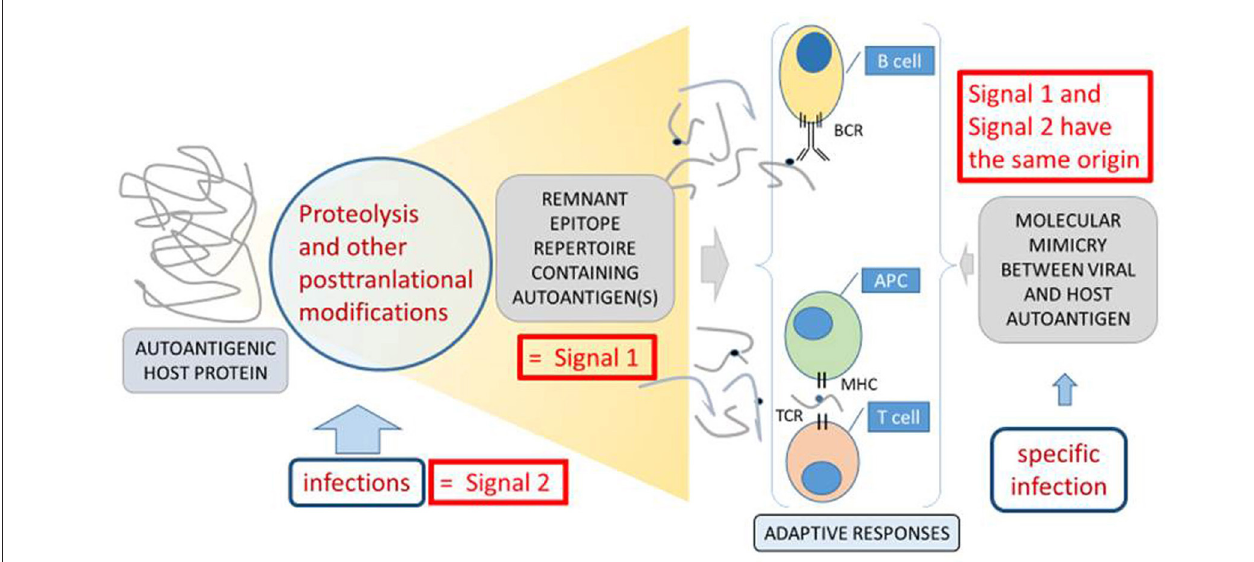
FIGURE 3 | Molecular mimicry, remnant epitopes and infections in VKH disease, as an example of autoimmunity. Two basic mechanisms of autoimmunity, molecular mimicry indicated at the right side ( 44) and remnant epitopes indicated at the left side (20) are compared. For the development of adaptive immune responses (indicated centrally at the bottom and between double braces), two signals are necessary (34). The so-called “signal 1” is the antigenic stimulus, which in the cases of autoimmune processes is an autoantigen, eliciting B cell or T cell responses through their cognate receptors (BCR and TCR). “Signal 2” is in most cases an environmental signal from an infection, which is translated at the molecular level into cell adhesion molecules or cytokines as reinforcers of the actions of the immunological synapse between an antigen-presenting cell (APC) and a T cell or in the activation of B cells. In the situation of molecular mimicry (44), the infection itself provides both the antigenic stimulus and the activation of adaptive immune cells. In this case “Signal 1” and “Signal 2” have the same origin and structural resemblance between a host autoantigen and a microbial epitope leads to cross-reactive “signal 1.” In the cases of remnant epitopes, various forms of infections may provide direct proteolysis and posttranslational modifications or induce host proteases and other enzymes. Their concerted actions lead to the generation of collections of autoantigenic peptides with an enhanced propensity to provide “signal 1,” when compared to healthy conditions. When this happens in the context of an infection or inflammation, the required “signal 2” is also present. Figure adapted from reference (